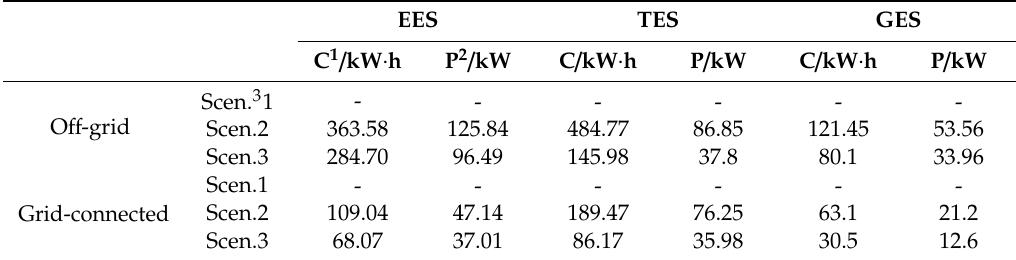
Table 4. The configuration